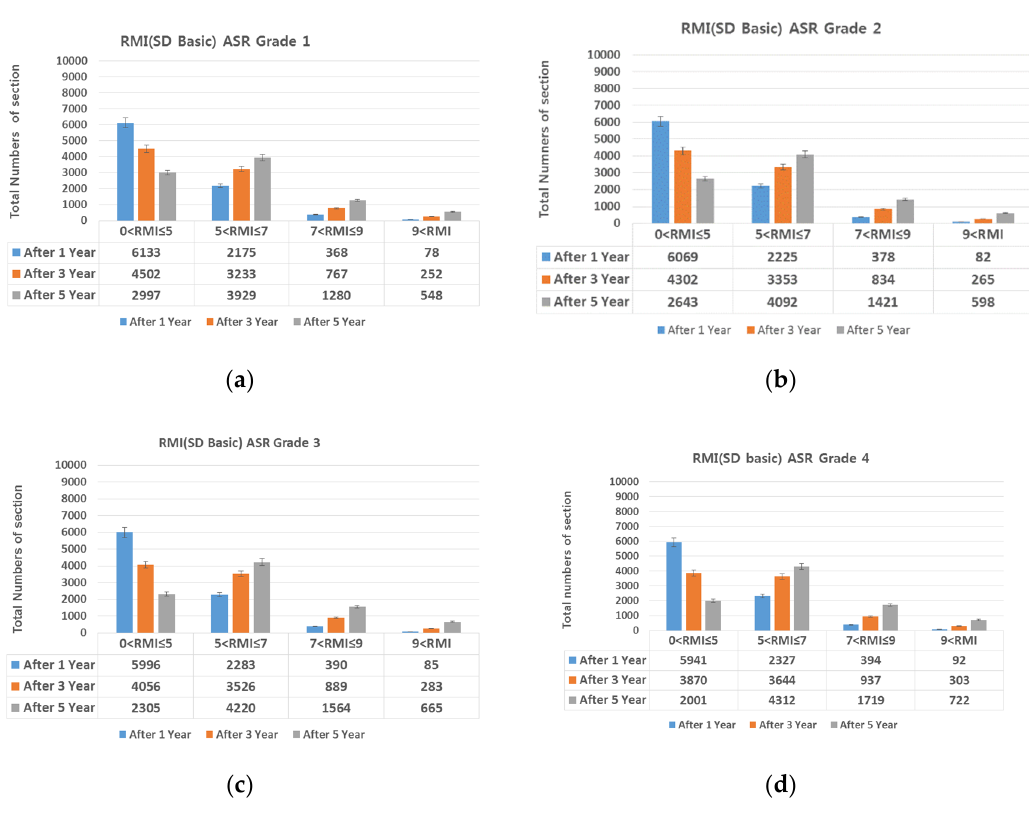
Figure 15. Change in number of sections per RMI with respect to surface distress (SD). ( a ) basic SD and ASR grade 1; ( b ) basic SD and ASR grade 2; ( c ) basic SD and ASR grade 3; and ( d ) basic SD and ASR grade 4.